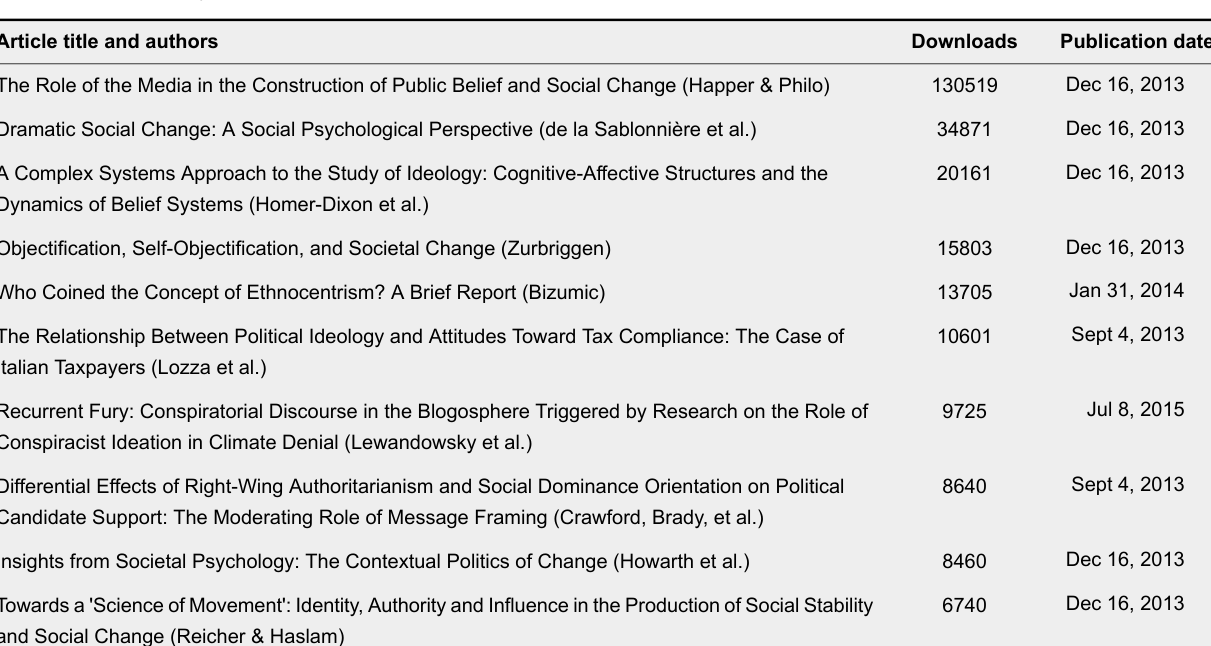
Top Ten Most Frequently Downloaded Articles Published Between 2013 and